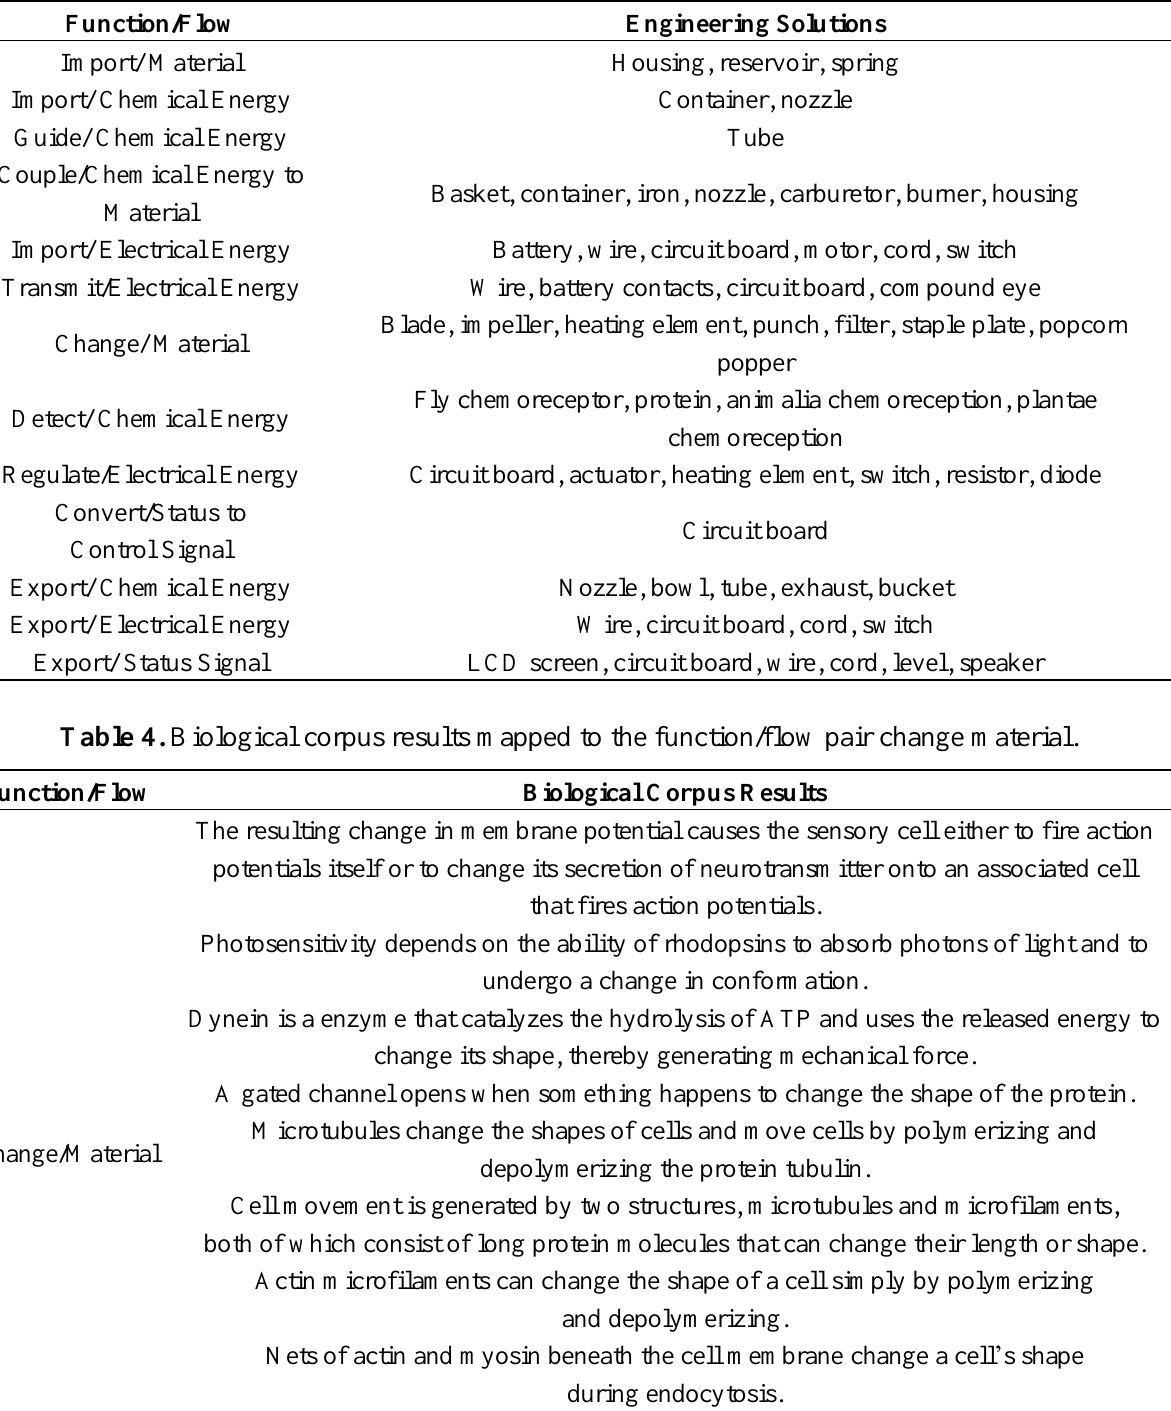
Table 3. Design repository results mapped to function/flow pairs.